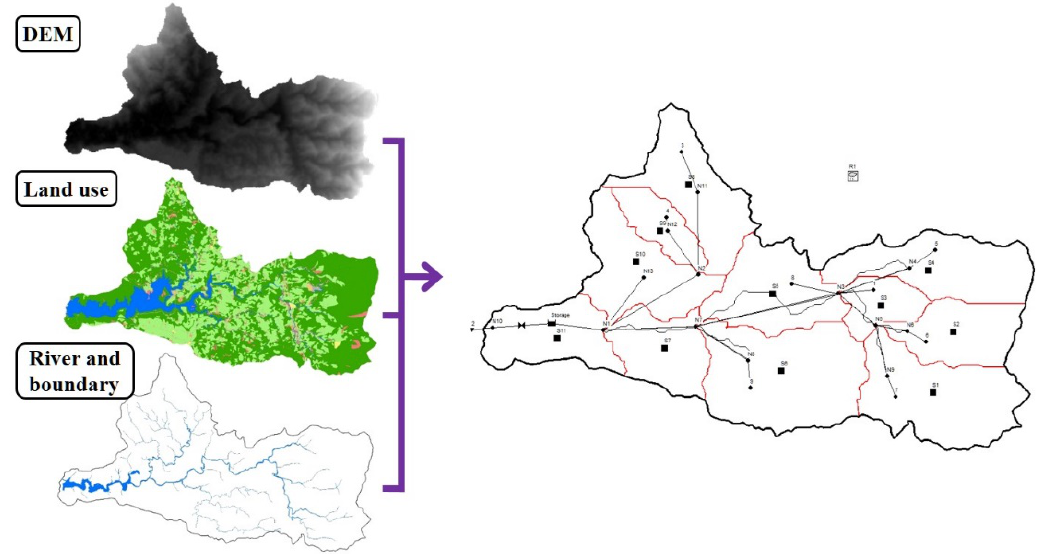
Figure 3. The GIS data were used to construct the stormwater management model (SWMM). The 11 subwatersheds are delineated for the Liyutan reservoir watershed.